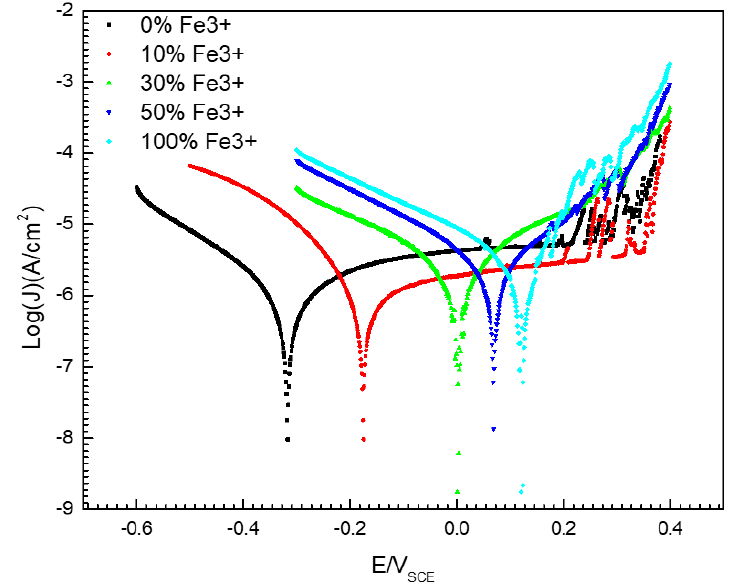
Figure 5. Potentiodynamic polarization curves of 304 SS in 0.1 mol/L iron ion solutions (deaerated) with different proportions of Fe 2+ /Fe 3+.